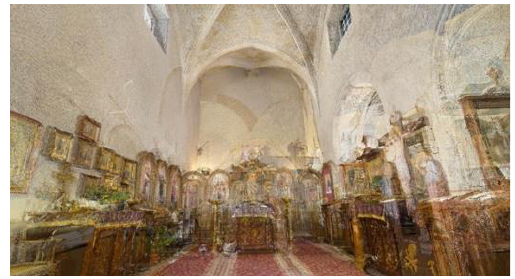
Figure 3 . Interior view of church point cloud.